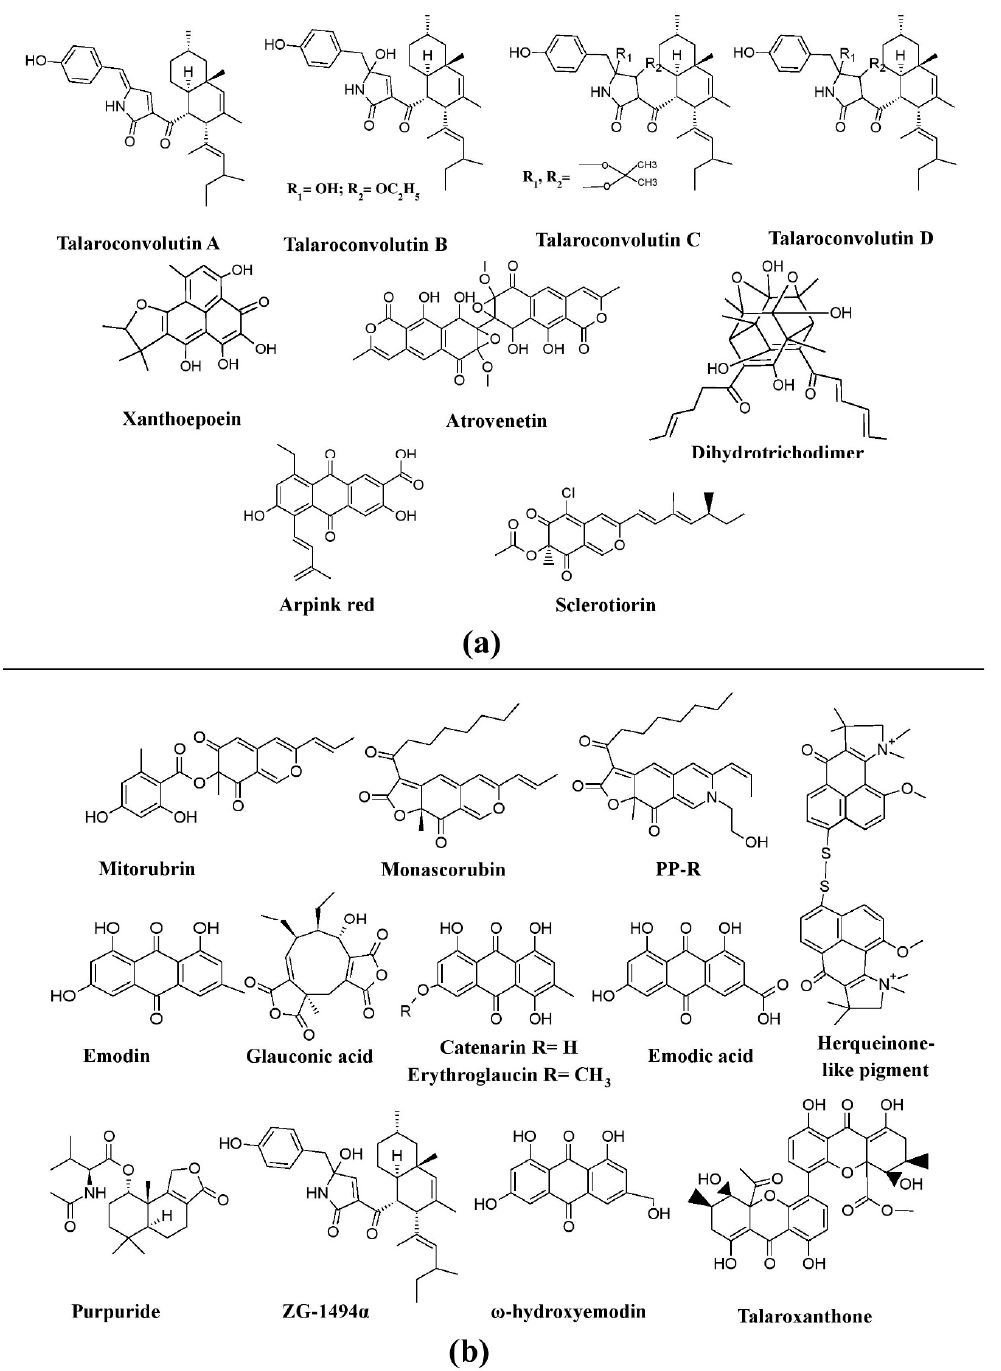
Figure 3. Pigments from the genera Penicillium and Talaromyces . ( a ) Different pigments produced by Penicillium species, re-drawn from [41,91,93,94,123]. ( b ) Various pigments produced by Talaromyces species, re-drawn from [100,101,107,109].